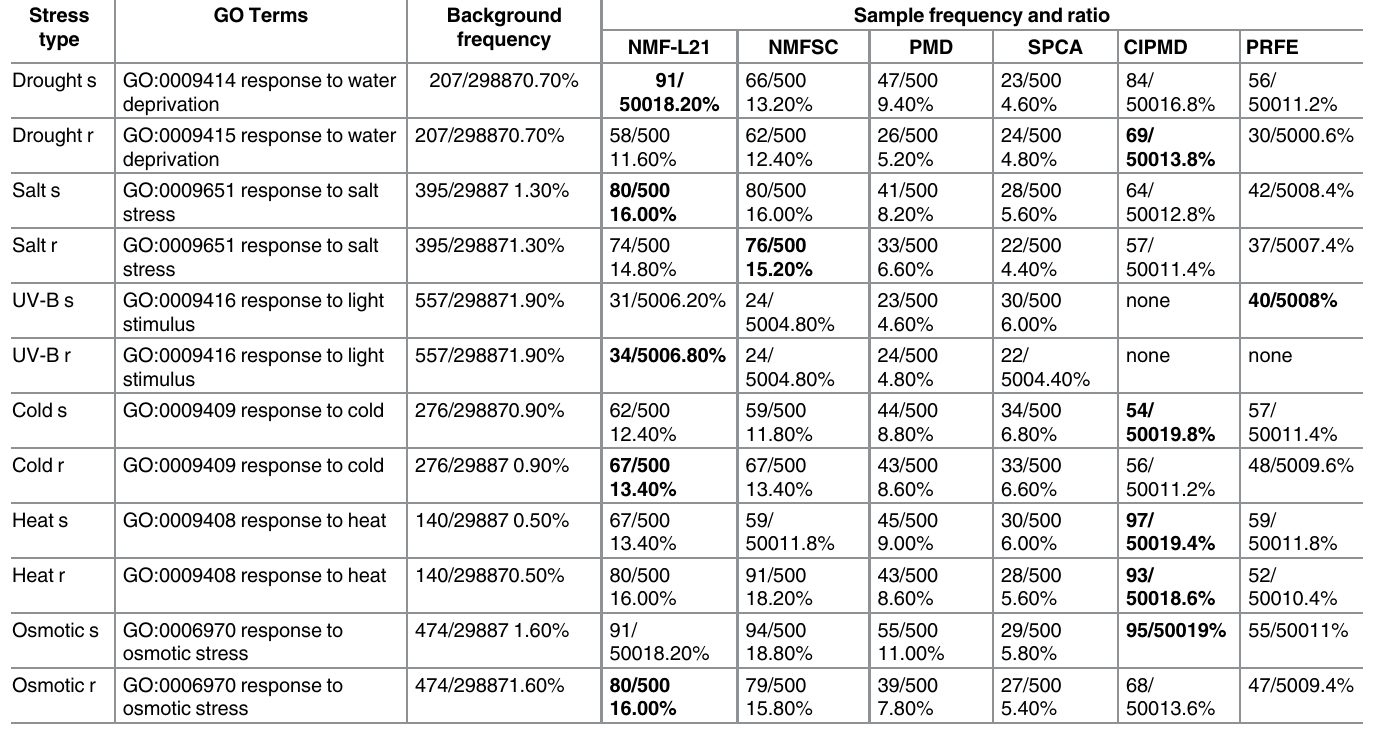
Table 5. Characteristic Terms Selected from GO by